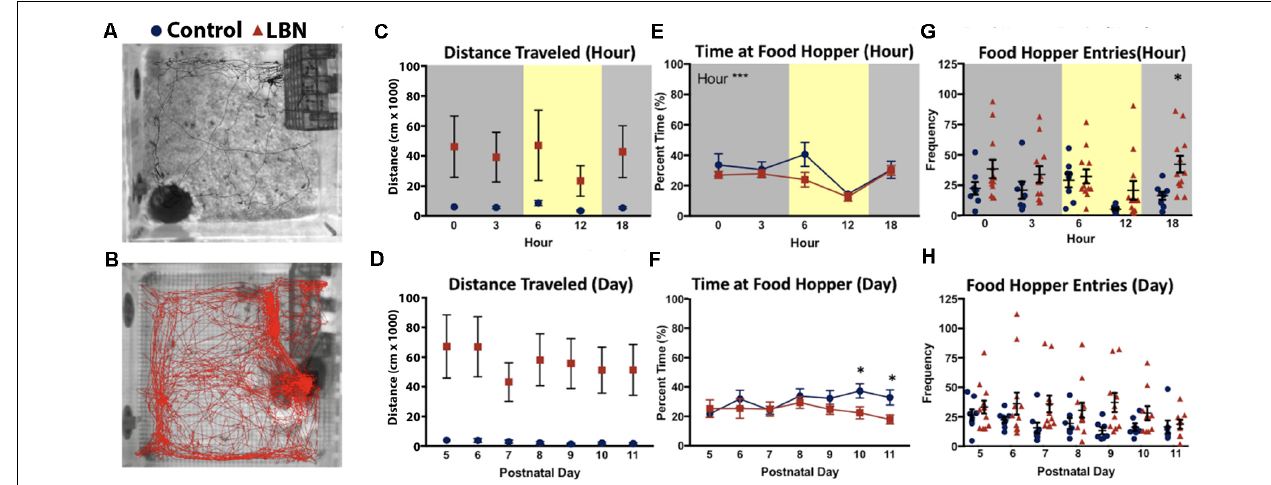
FIGURE 2 | LBN rearing influences off nest behaviors of dams. Representative images of paths traveled by (A) control (black) and (B) LBN (red) dams for 1 h during the light cycle. (C) No main effect of condition, hour, or condition × hour interaction were found for distance traveled over the circadian cycle. (D) No main effect of condition, day, or condition × day interaction were found for total distance traveled across the 7-day manipulation. (E) A significant effect of hour ( F ( 4,27.1 ) = 14.58, p = 1.81 × 10 − 6 ) was found for percent time at food hopper, but no effect of condition or condition × hour interaction over the circadian cycle. (F) No main effect of condition, day, or day × hour interaction were found for time at the food hopper. However by days P10 and P11, controls spent more time at the food hopper than LBN dams. (G) For food hopper entries no main effect of condition, hour, or hour × condition interaction were found. However, at 18:00, LBN dams approached the food hopper more frequently than controls (18:00; t ( 15.4 ) = 3.41, p = 0.004). (H) Across the 7 days of the manipulation, no main effect of condition, day, or day × condition effects reached significance for food hopper entries.